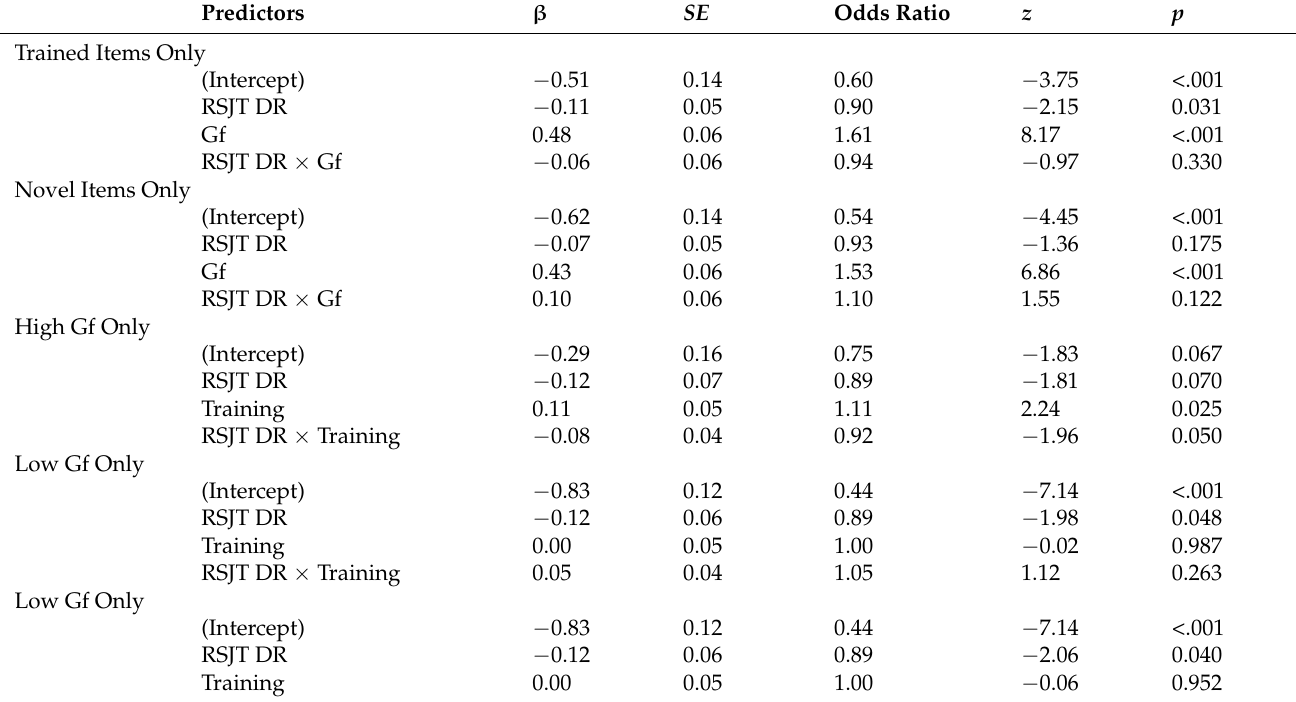
Table A4. Post hoc comparisons: RSJT different-rule × Gf ×